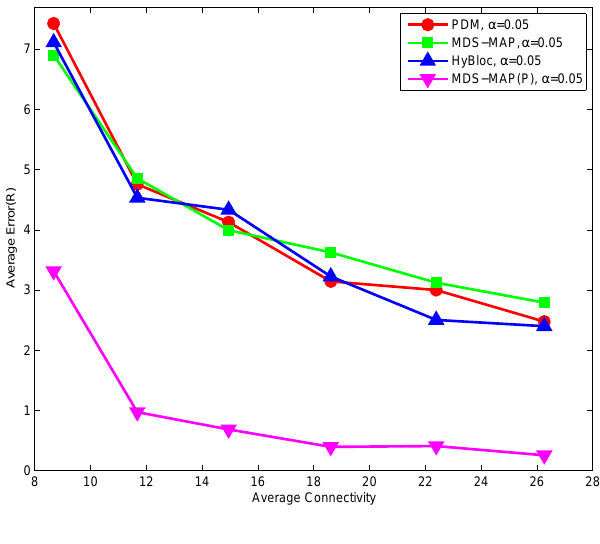
Figure 19 . 5 Anchors, α =0.05, C-shaped